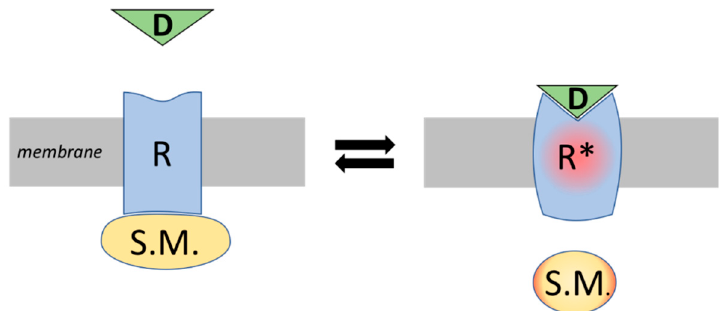
Figure 2. The drug-receptor concept in Western science. The paradigm is “Corpora non agunt nisi fixate”, a drug (D) will not work unless it is bound to a specific target, e.g., a receptor (R). Binding of the drug to the receptor will cause a conformational change of the structure of the receptor (R*). This triggers the production of a second messenger (S.M.), which will finally result in a strong effect in the cell.